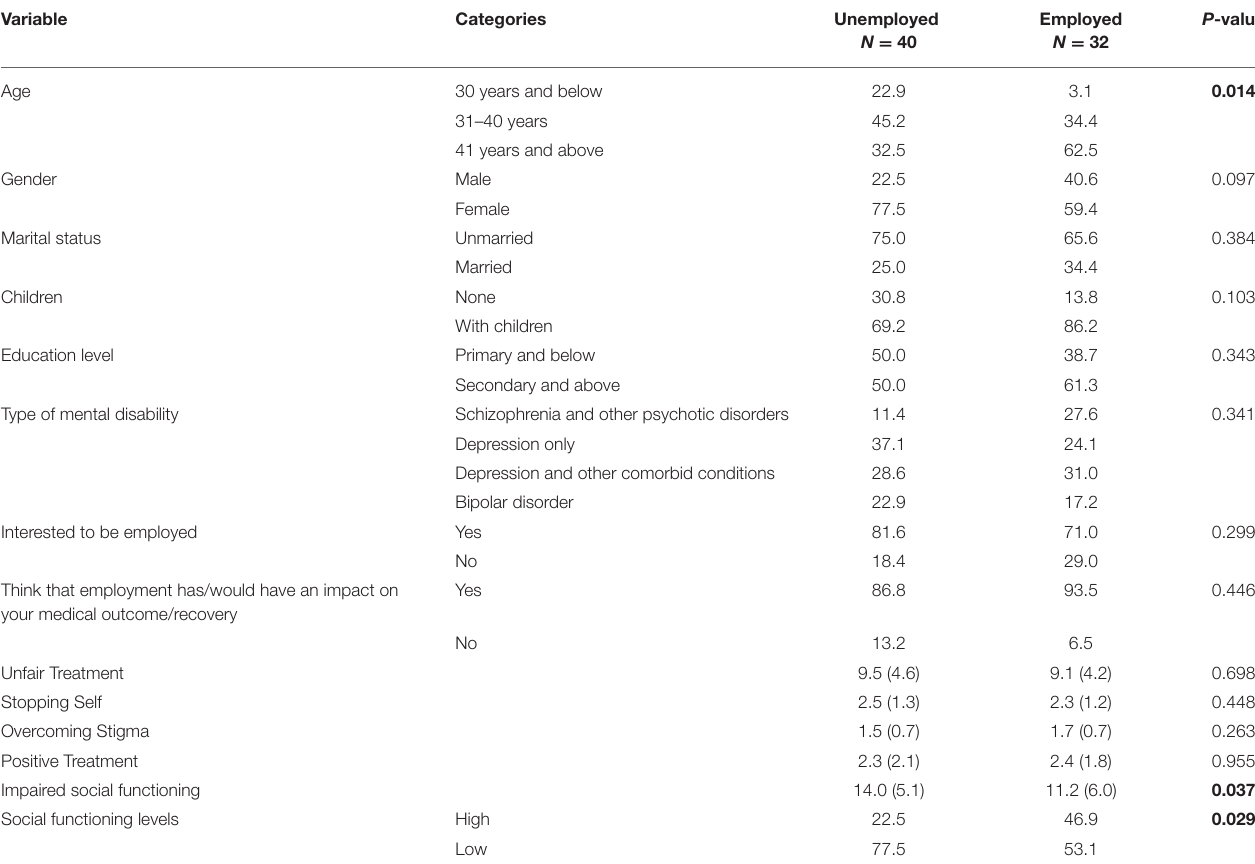
TABLE 5 | Factors associated with